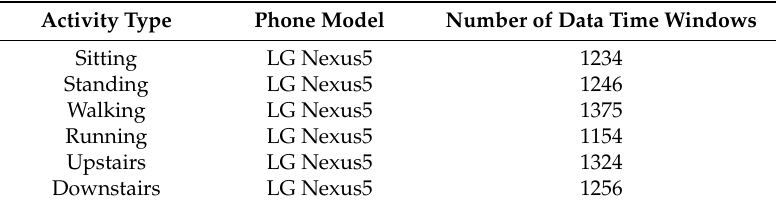
Table 2. Testing datasets collected from 20 participants (Data collection